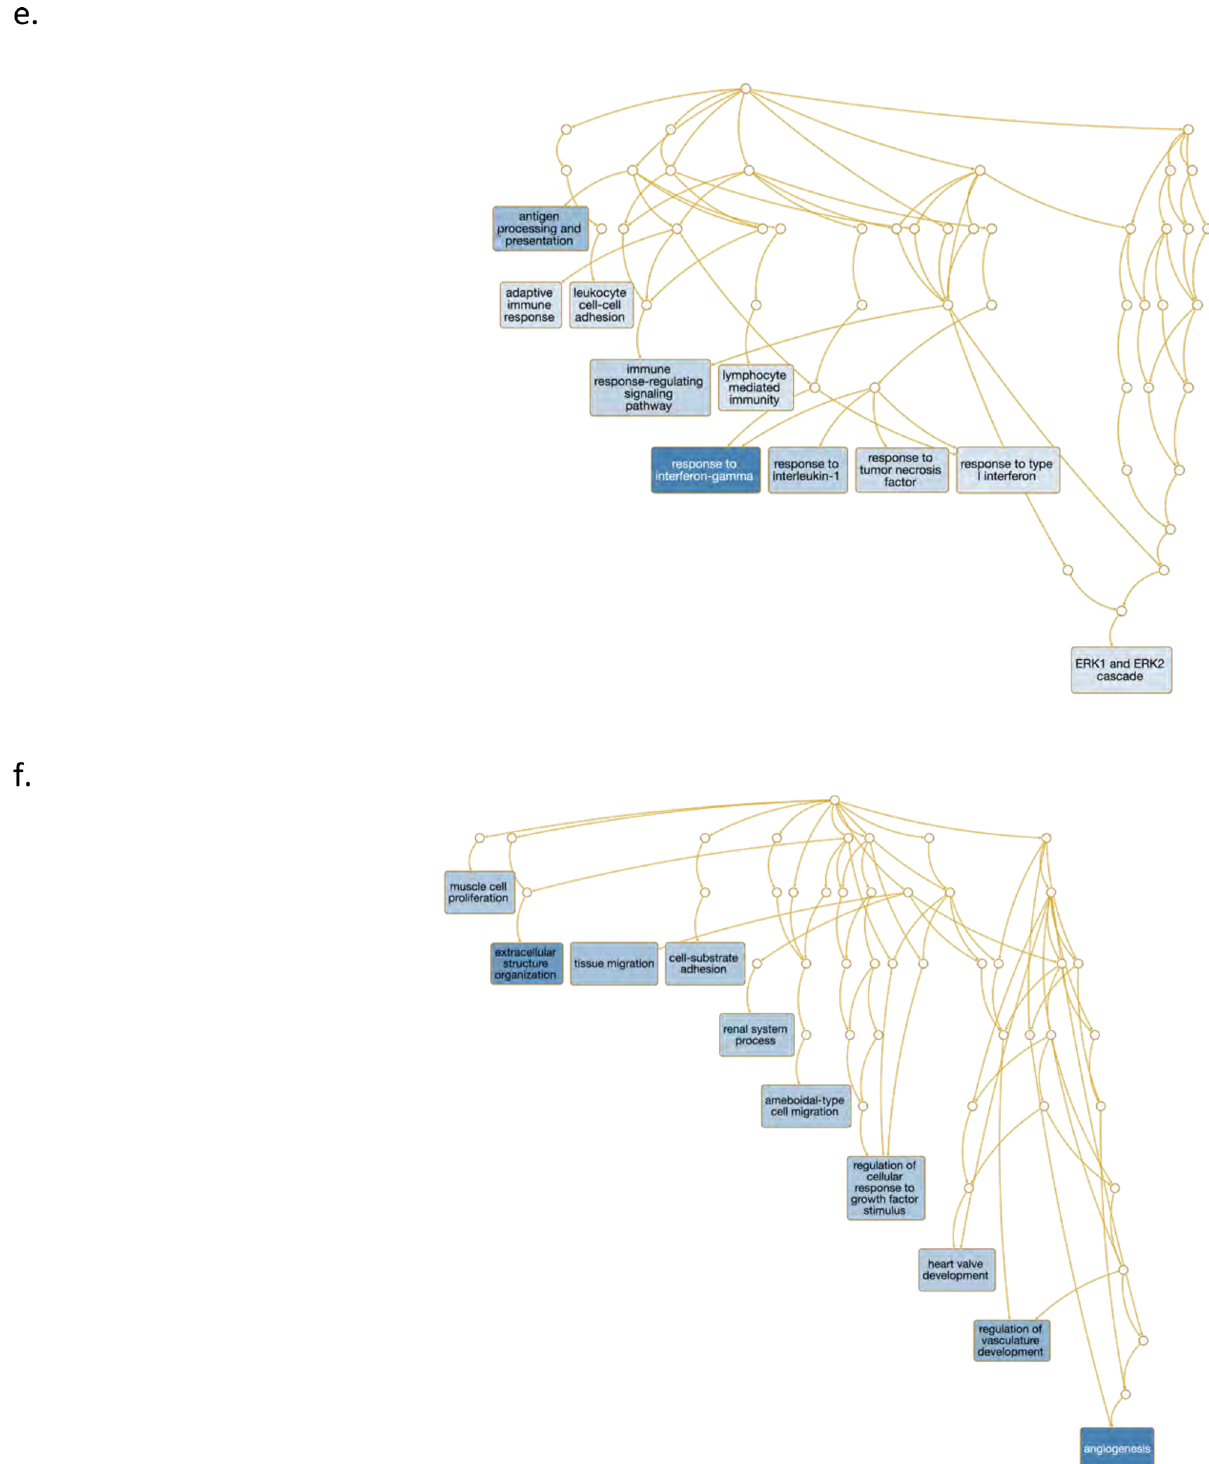
Table S1. Plaques were characterized by histopathology according to AHA classi- fi cation scheme 76 . Brie fl y, near full thickness (except adventitia) sections of artery and plaque were recovered from the atherosclerotic core, based on surgeon ’ s determination of area of largest plaque burden, usually near the carotid bifurcation. A section of artery located ~1 cm proximal to the AC was then recovered from the same patient during the cut-down portion of the endarterectomy, resulting in